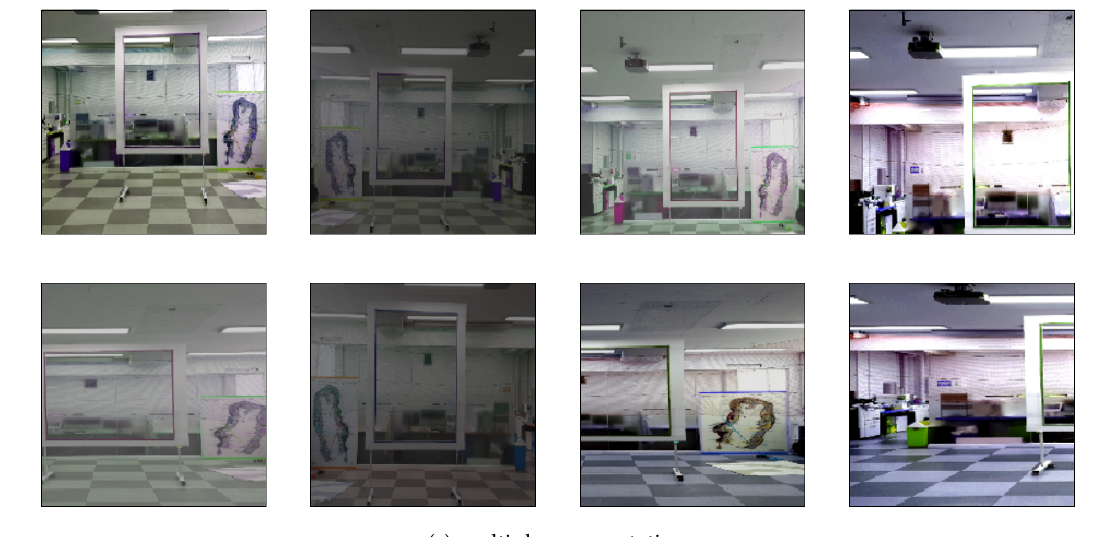
Figure 6. Images with random hue, color jitters and multiple augmentation used for training.